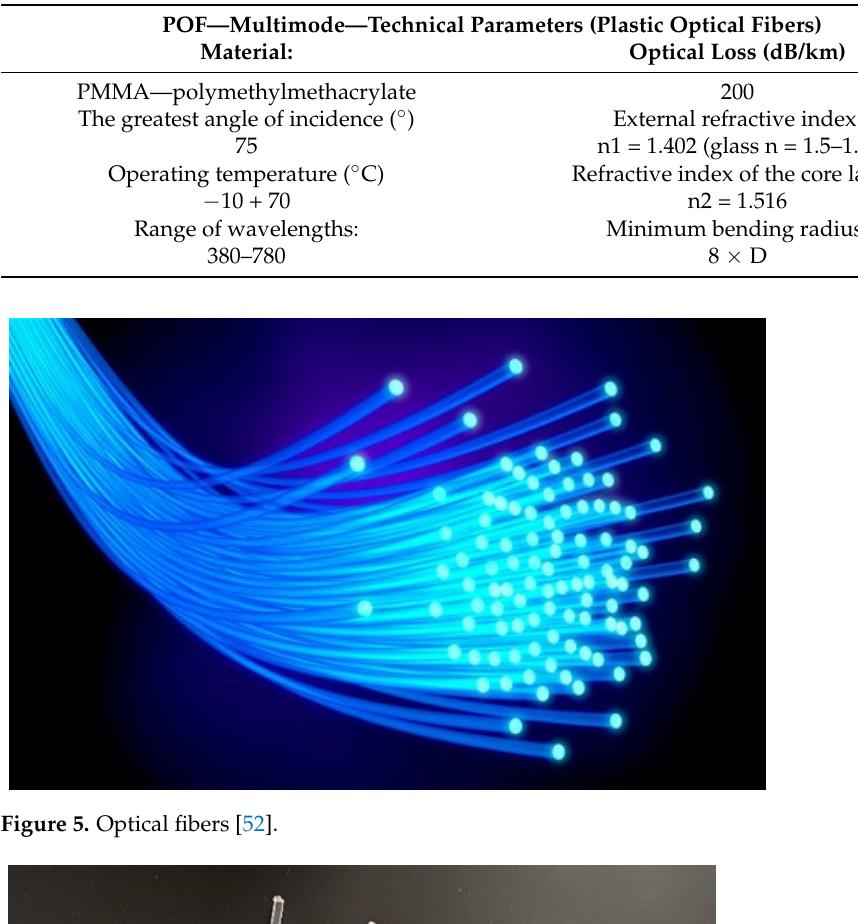
Table 3. Plastic optical fibers (POF)—multimode—technical parameters.